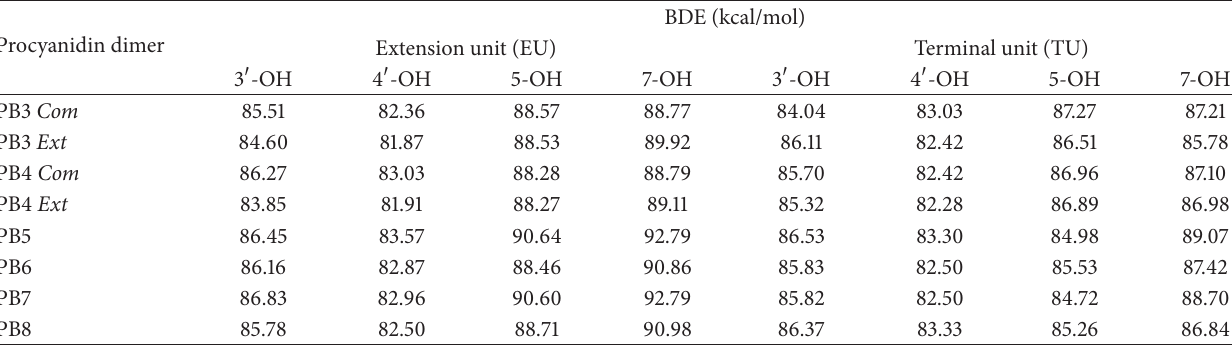
Table 3: Bond dissociation enthalpy (BDE) of the procyanidin dimers calculated in aqueous medium (SMD model) using the M05-2X/6- 31 G ∗∗ DFT method.